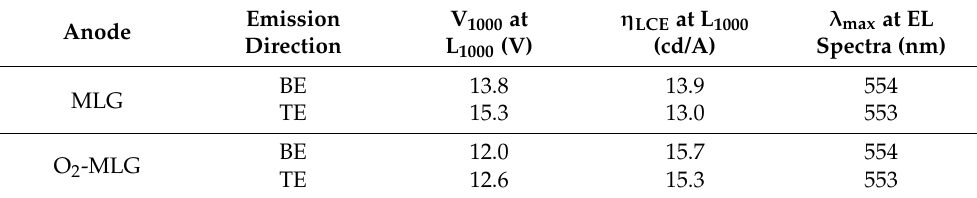
Table 1. J–V–L characteristics of MLG and O 2 -MLG